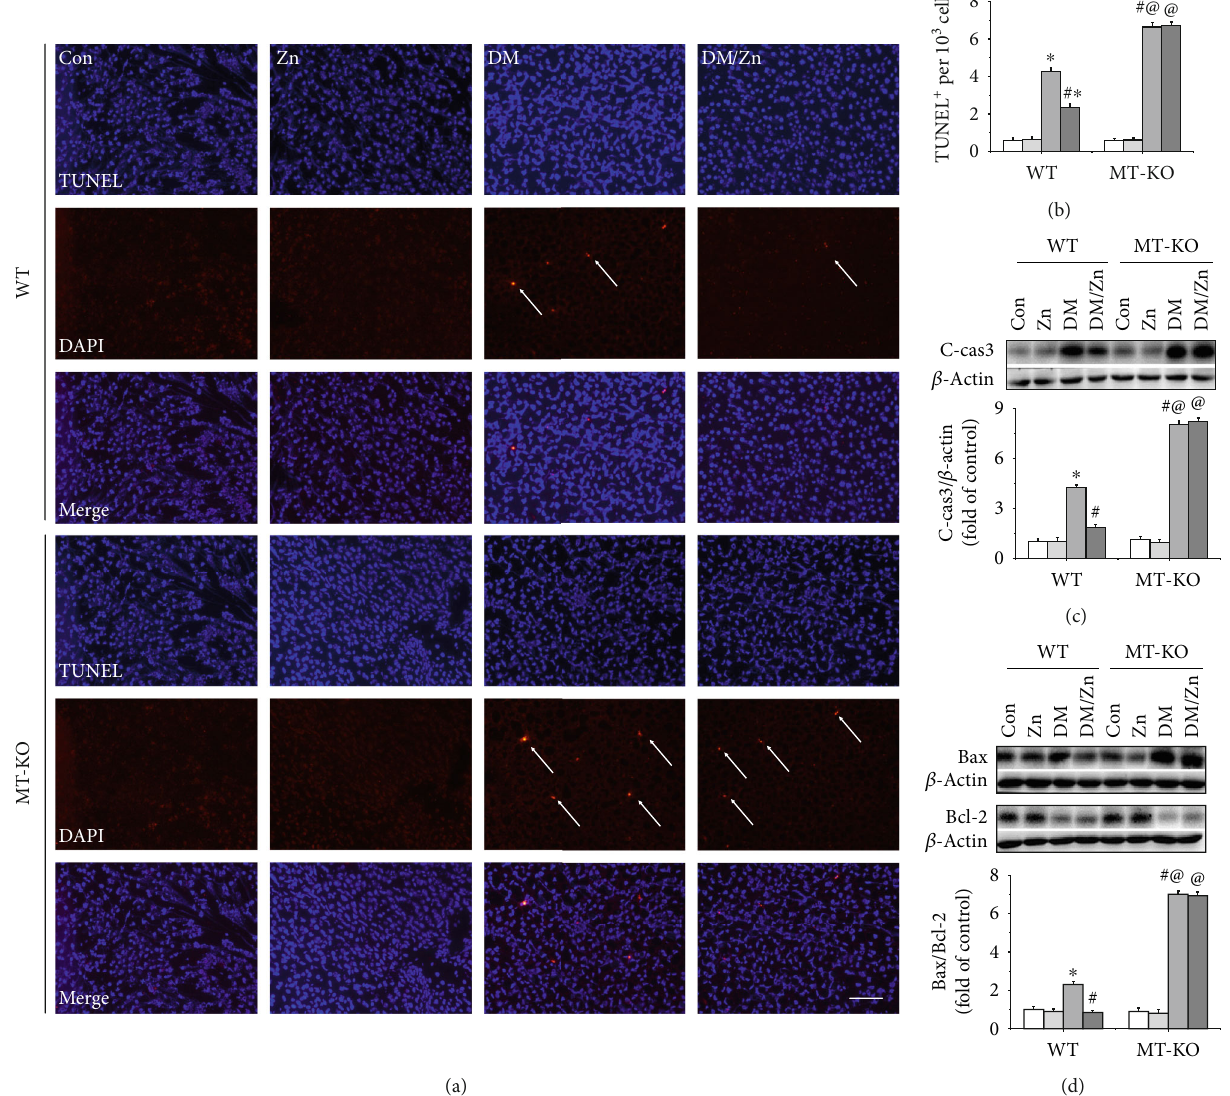
Figure 7: The role of endogenous MT in zinc supplementation-induced antiapoptotic e ff ect in the liver of type 2 diabetic mice. Hepatic apoptosis was examined by TUNEL staining (a), followed by the quantitative analysis of the positive cells (b). Hepatic expression of apoptotic cell death factors, including cleaved-caspase3 (C-cas3) (c) and Bax/Bcl-2 (d), was examined by western blot analysis. Data are presented as the mean ± standard deviation ( n = 8 /group). ∗ P < 0 : 05 vs. the control (Con) group in WT mice; # P < 0 : 05 vs. the type 2 diabetes (DM) group in WT mice; @ P < 0 : 05 vs. the control (Con) group in MT-KO